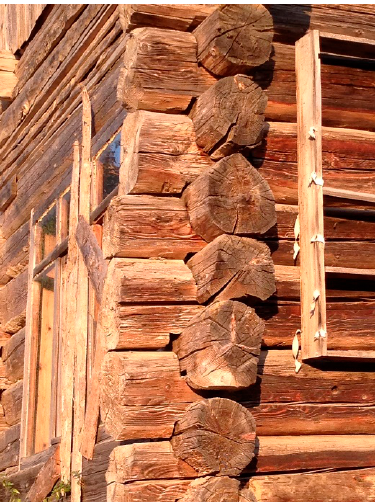
Figure 8. Structural solutions by using organic materials of the region, corner connection detail of wooden masonry (Photographed by Ömer Faruk Bayram).